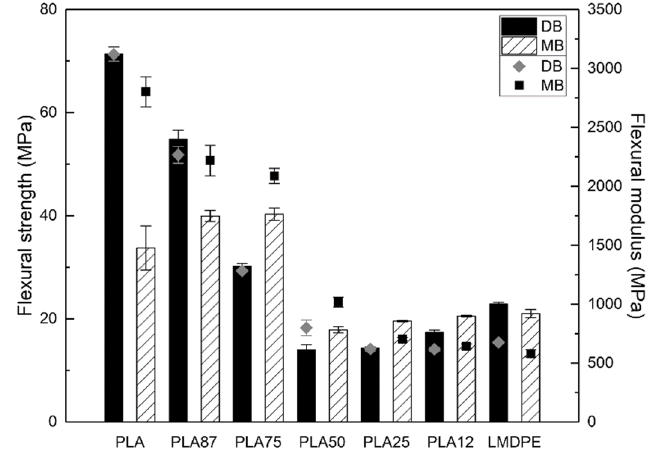
Figure 8. Flexural properties of the rotomolded parts: Strength (column bars) and modulus (closed symbols).